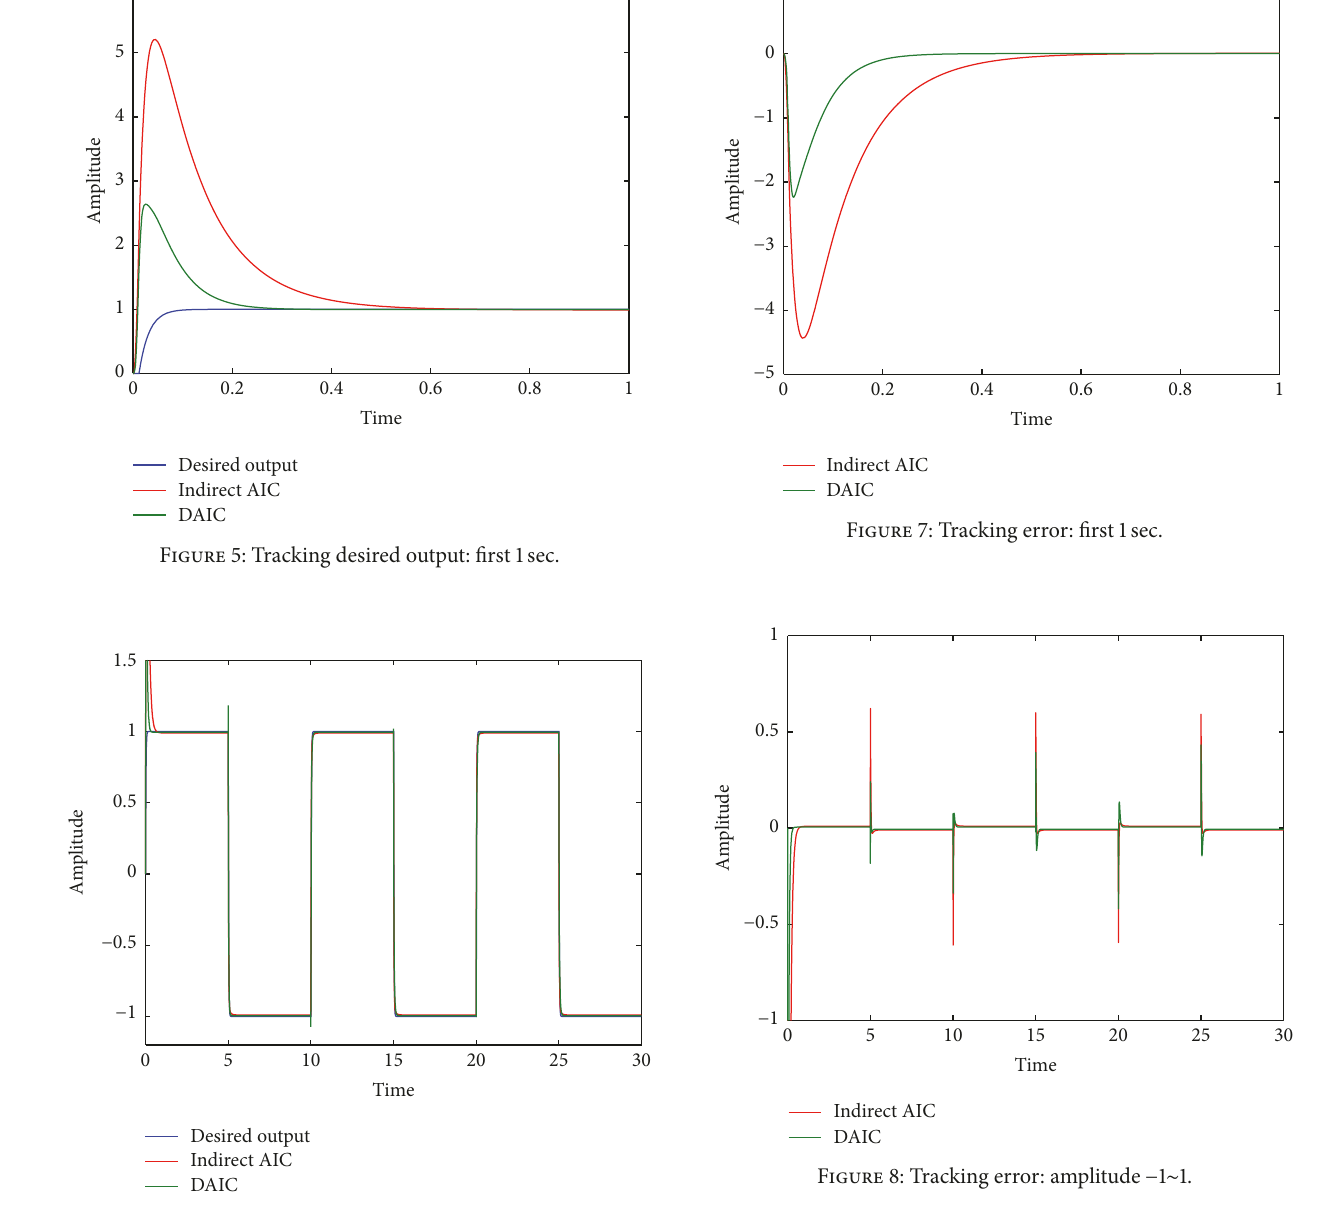
Figure 6: Tracking desired output: amplitude − 1.2 ∼ 1.5.